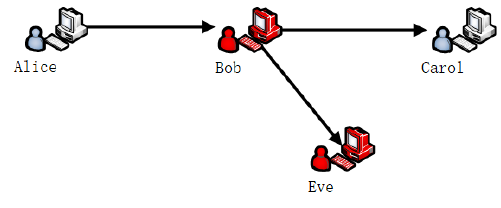
Figure 2. Forked By Malicious Data